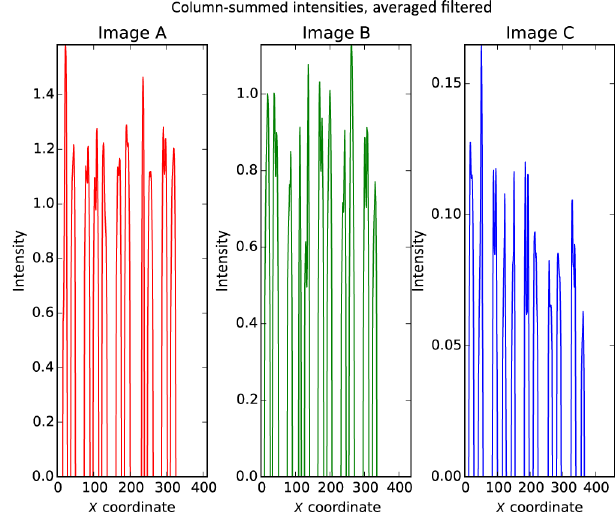
Figure 9. The column-summed intensities of the clock displays of images A, B and C (Figs. 4, 5 and 6) after extracting the clock dis- play from the full image.